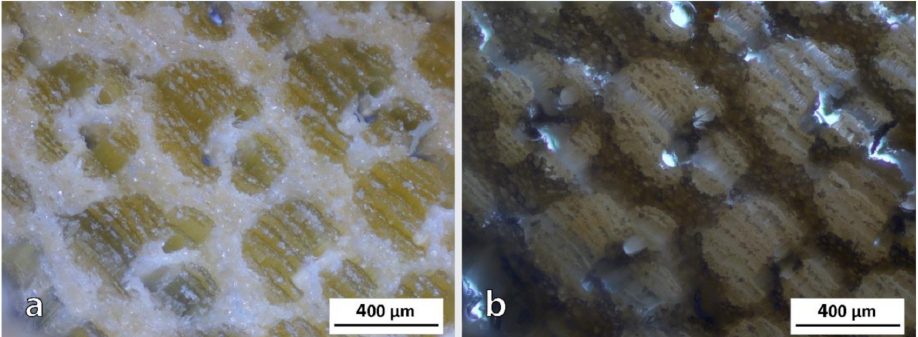
Figure 2. OM micrographs from the cross-section of AA bamboo as obtained by ( a ) reflection and ( b ) transmission modes.